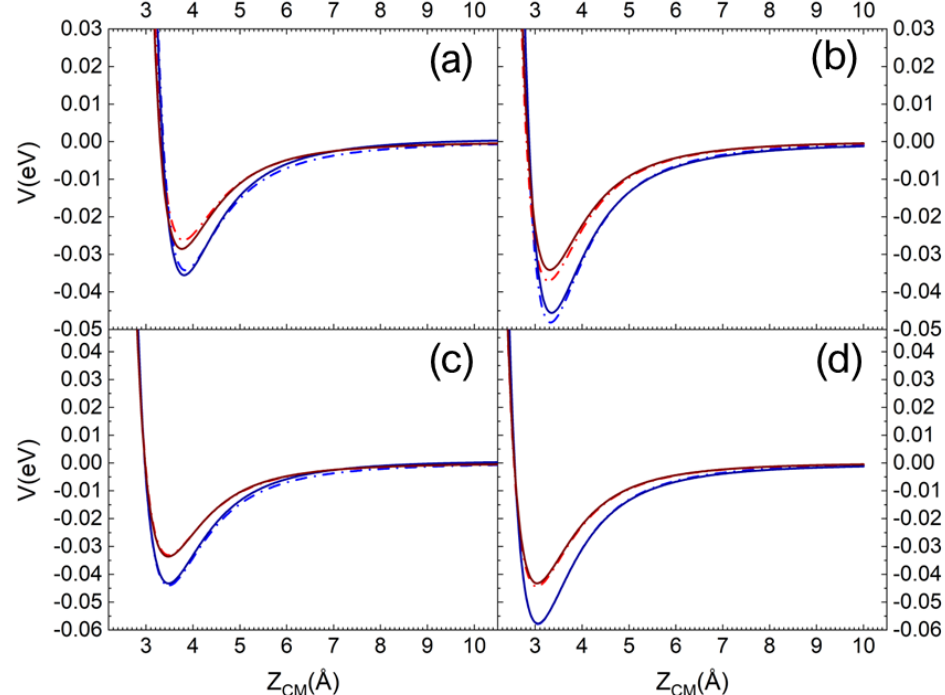
Figure 1. ILJ contribution (dash-dot line) and complete interaction potential (solid line) for N 2 molecule interacting with molecular axis ( a ) perpendicular and ( b ) parallel to the surface plane on a Si surface atom. ( c , d ) the same but for N 2 impinging on an O atom in the first sublayer. The red and blue lines are for the interaction on the cristobalite and quartz, respectively.